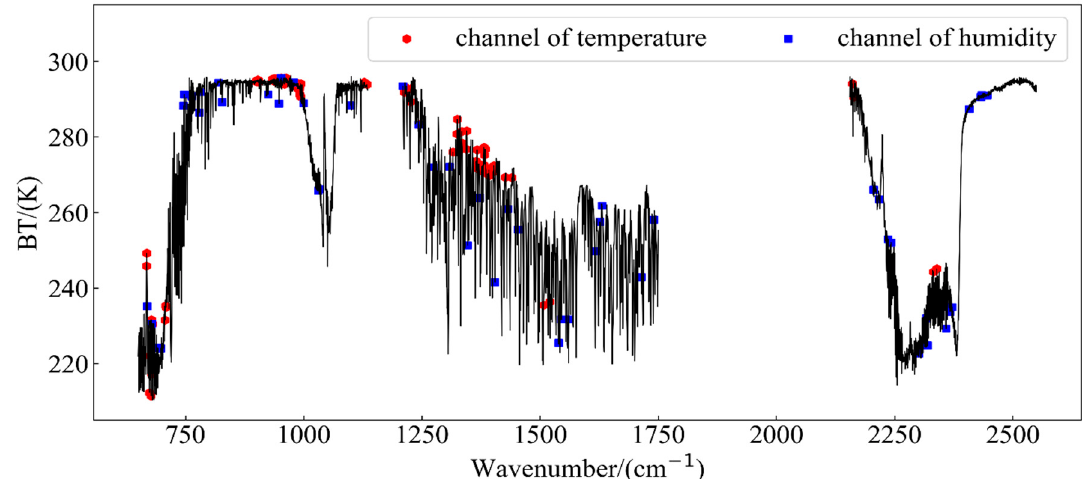
Figure 3. The position of channel selection about temperature and humidity in the spectrum.